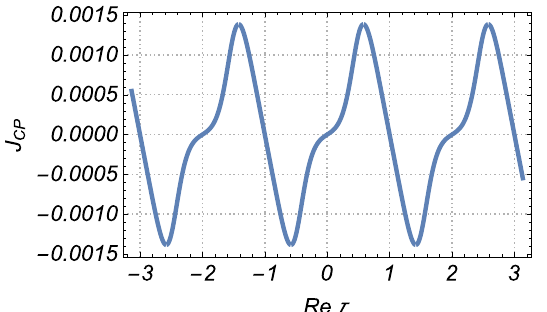
Figure 1 . The relationship between a real part of the complex structure modulus Re τ and the Jarlskog invariant J CP in Sample II.